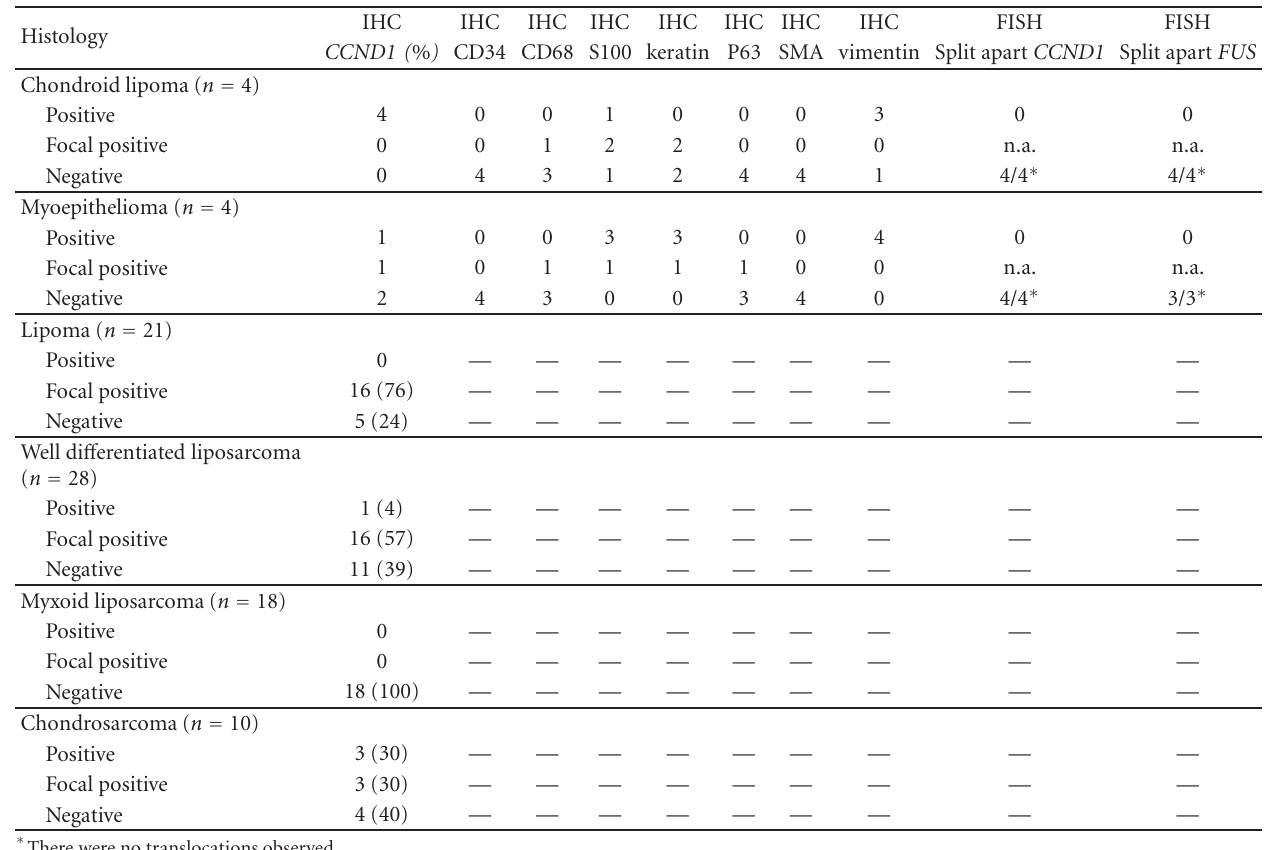
Table 2: Immunohistochemical and fluorescence in situ hybridization